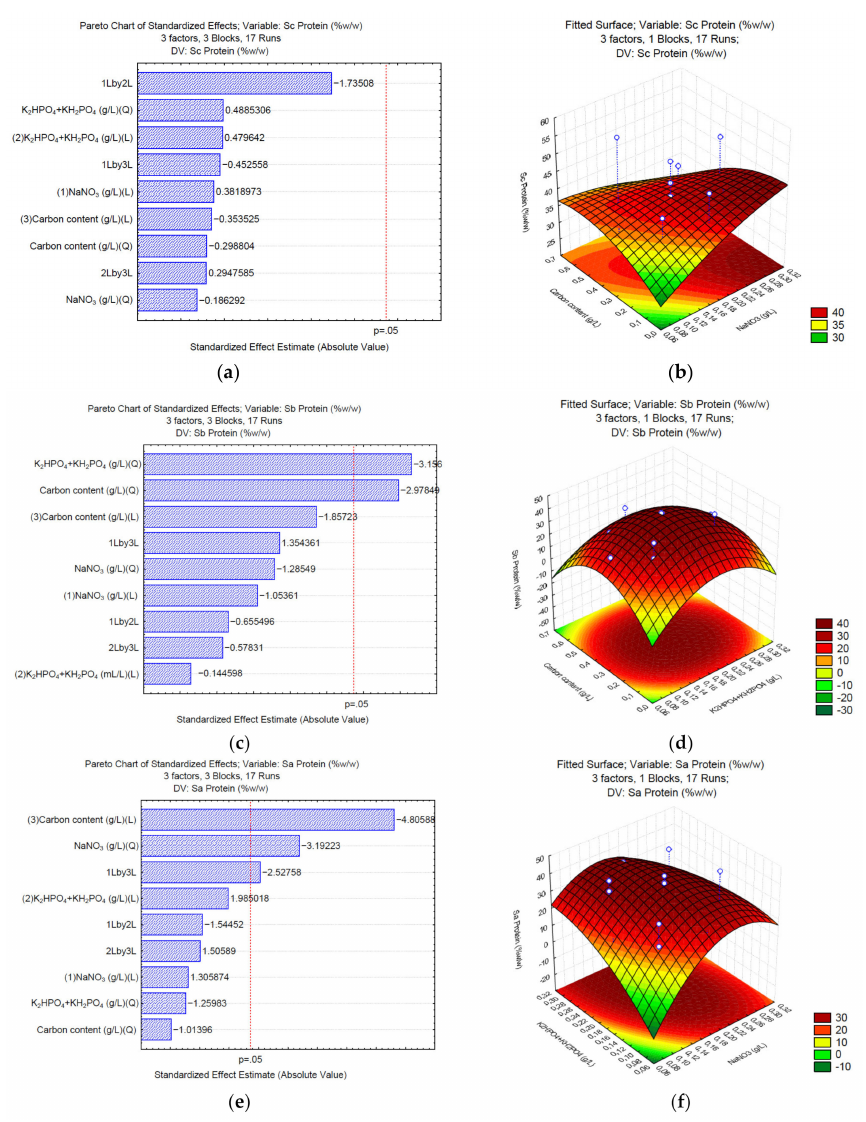
Figure 2. Pareto charts and surface response of protein production using Na 2 CO 3 ( a , b ), NaHCO 3 ( c , d ), and C 2 H 3 NaO 2 ( e , f